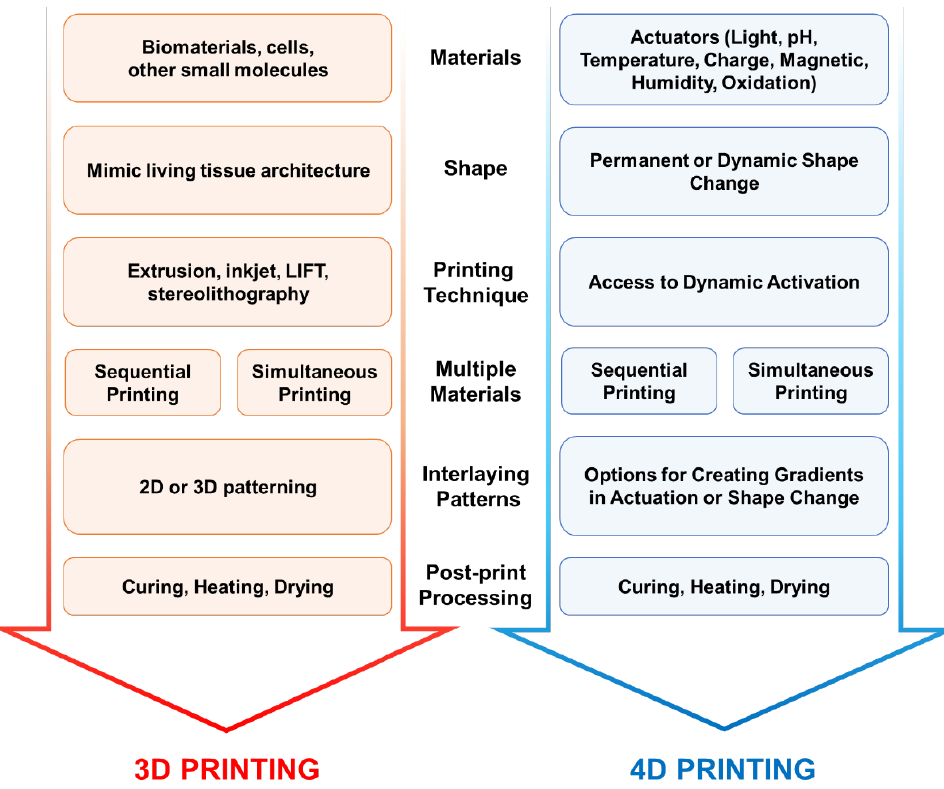
Figure 6. Design considerations for 4D printing of smart hydrogels.